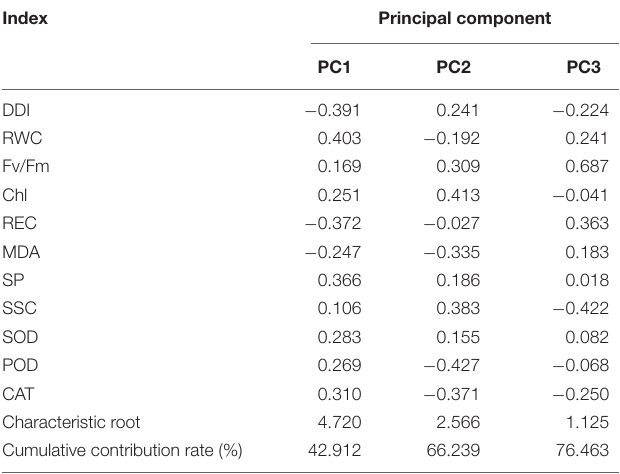
FIGURE 7 | Principal component analysis of different indicators.